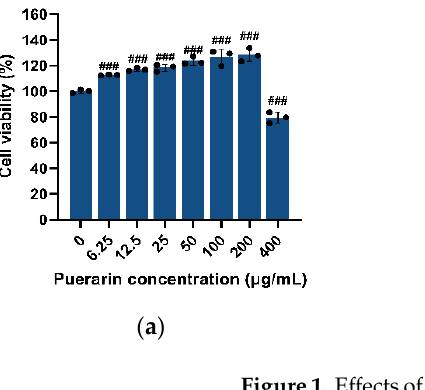
( c ) Figure 2. Effects of puerarin on cellular antioxidant indexes: ( a ) Effects of puerarin on total antioxi ‐ dant capacity of HSF with UVA ‐ induced oxidative damage. ( b ) Effects of puerarin on reactive oxy ‐ gen species (ROS) production induced by UVA stimulation. ( c ) Effects of puerarin on lipid oxidation product malondialdehyde (MDA) content in HSF with UVA ‐ induced oxidative damage. ## p < 0.01, ### p < 0.001 as compared to the control group; * p < 0.05, *** p < 0.001 as compared to the damage model group; Values do not have a common mark ( # , *) when p > 0.05, ( n = 3). The effects of puerarin on the KEAP1 ‐ Nrf2/ARE signaling pathway in UVA oxida ‐ tively damaged cells were investigated in this work from two perspectives: protein con ‐ tent and mRNA expression level. The Puerarin solution reduces the relative mRNA tran ‐ scription of KEAP1 from 1.743 to 1.302 (Figure 3a) and the protein content from 51.68 to